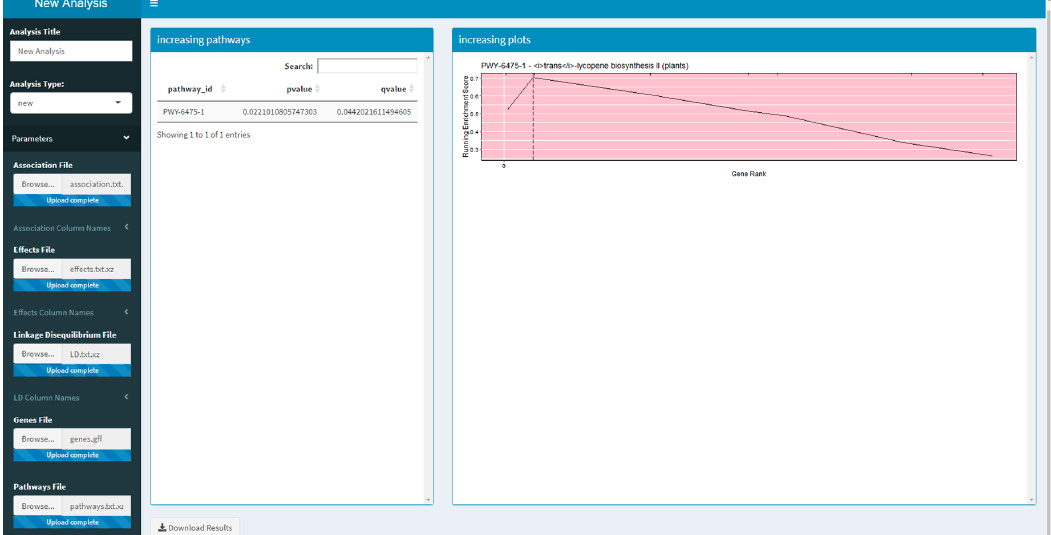
Figure 1. A screenshot of the R Shiny application running the Pathway Association Study Tool (PAST).